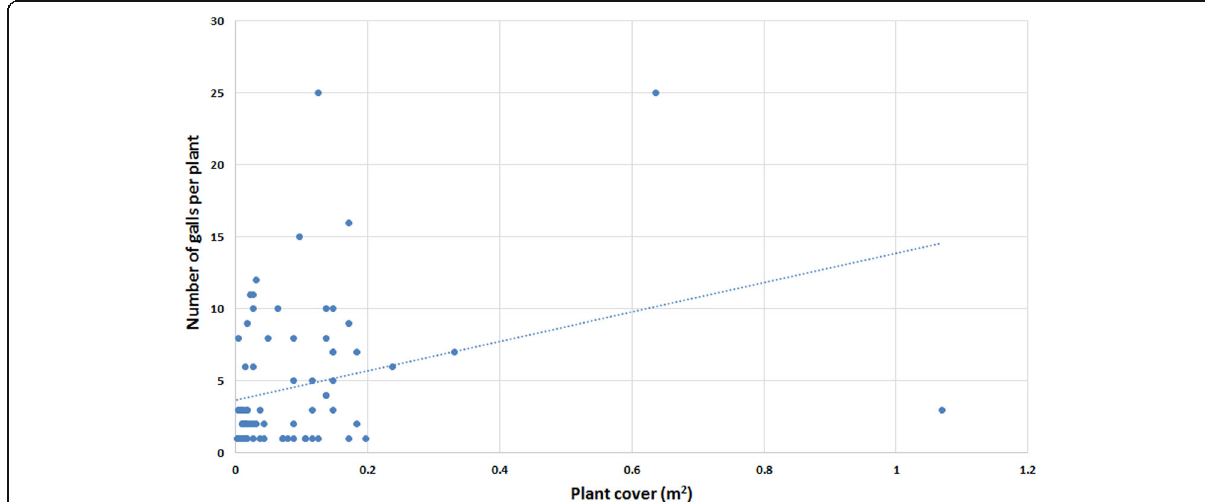
Fig. 4 The relationship between the number of galls per plant and the plant cover within the study localities